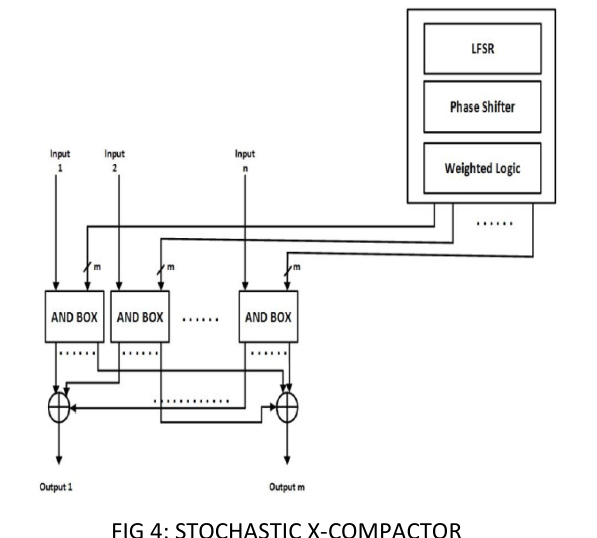
FIG 4: STOCHASTIC X-COMPACTOR This configuration has multiple layers, each layer having multiple number of stochastic X compactors and is called as “X-sand filter”. “X-sand filter” filters out X’s from the output data in a layer after layer configuration like a sand filter does. Each unit in the configuration is a space compactor (stochastic X- compactor or X-compactor) with a limited capability of compaction and X-tolerance, for the